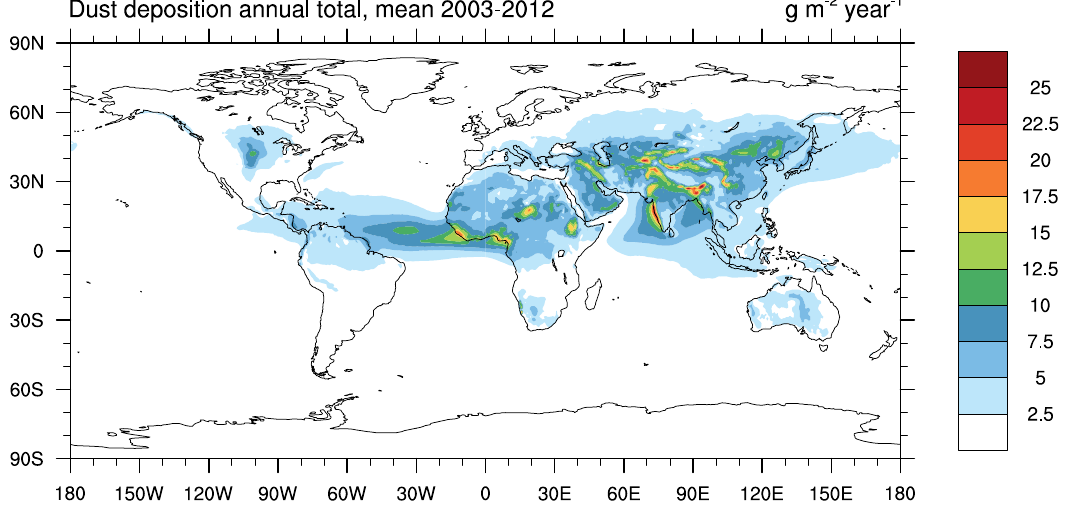
Figure 3. Annual total dust deposition fluxes (g m − 2 year − 1 ) averaged over the 10-year period 2003-2012. Shown deposition rats include dry deposition, sedimentation, wet deposition due to large-scale precipitation and wet deposition due to convective precipitation. Data are taken from the ECMWF MACC reanalysis data set at 6-hourly resolution (0UTC, 6UTC,12UTC, and 18UTC) and 0.75 ◦ × 0.75 ◦ grid